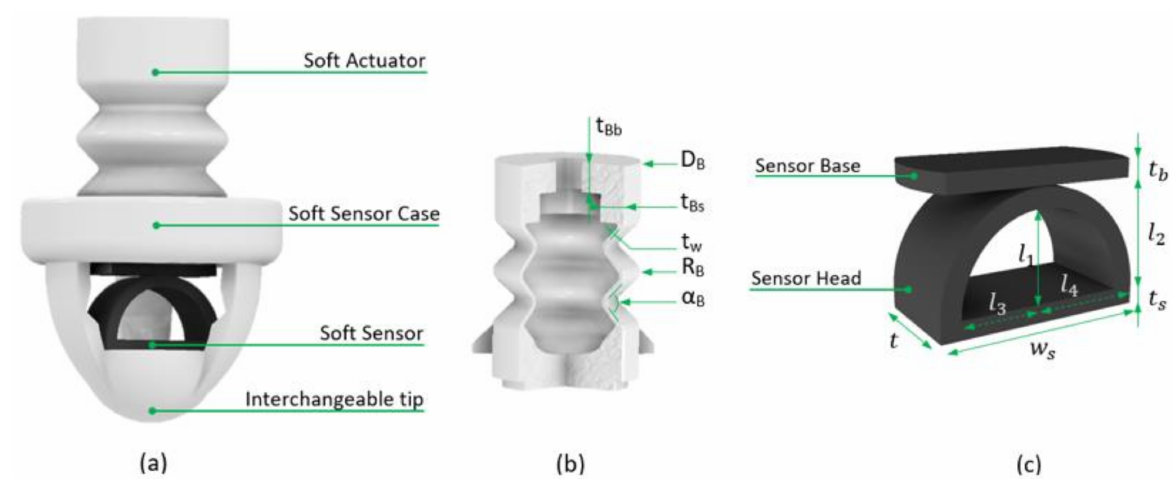
Figure 1. Three-dimensionally printed soft haptic system (SoHapS): ( a ) SoHapS complete system. ( b ) The actuation component of SoHapS consists of a bellow actuator with the following dimensions in mm: D B , 14.00; t Bs , 2.87; t w , 0.45; RB, 1.12; α B , 90 ◦ . ( c ) The sensing component of SoHapS consists of a soft force sensor of semi-elliptical shape with the following dimensions in mm: t s , 1.00; t b , 1.00; t, 6.00; w s , 11.40; l 1 , 4.95; l 2 , 6.00; l 3 , 4.60; l 4 ,